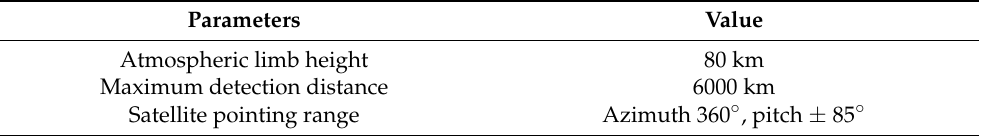
Table 2. Simulation configuration